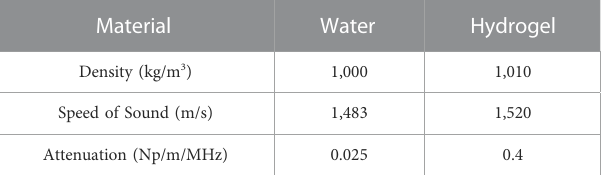
TABLE 1 Acoustic, thermal, and mechanical properties of water and a PEG- based hydrogel.